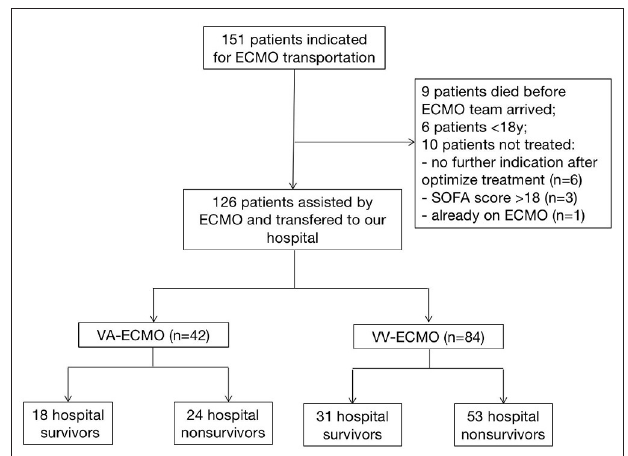
FIGURE 1 | The flow